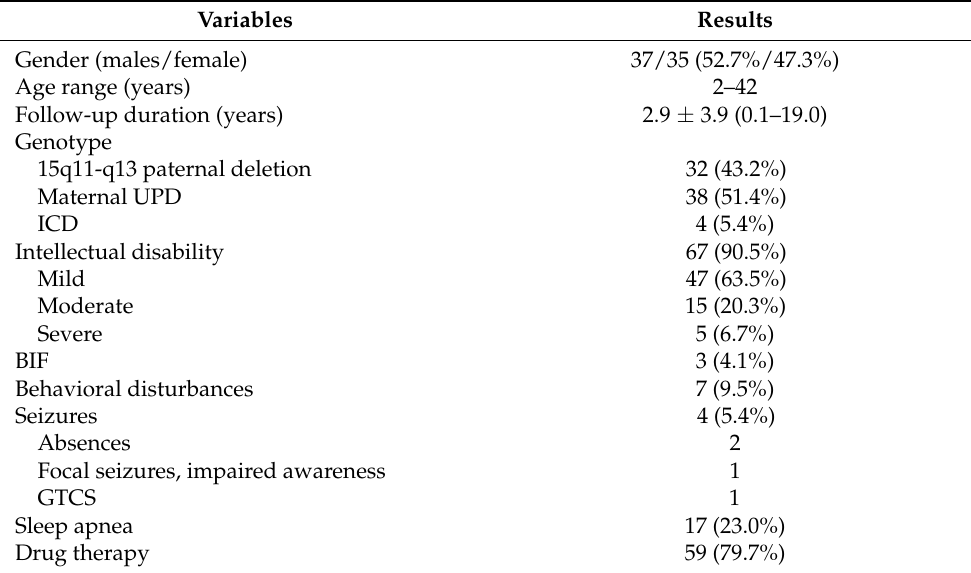
Table 1. Demographic and clinical features of the patients with Prader–Willi syndrome ( n = 74).